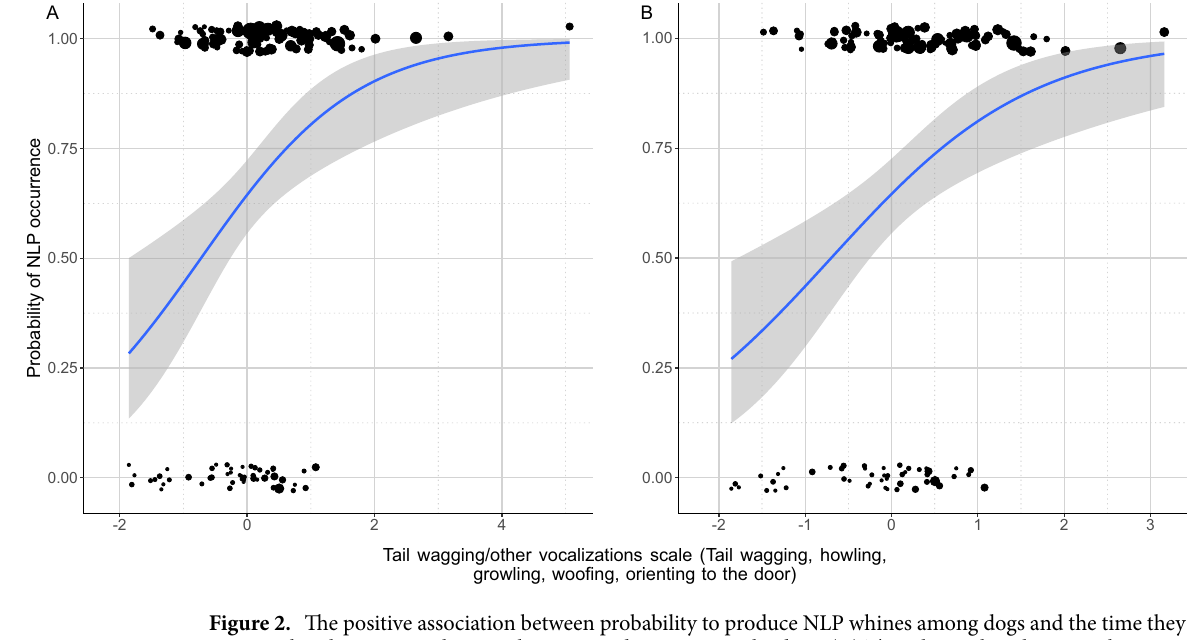
Figure 2. The positive association between probability to produce NLP whines among dogs and the time they spent with tail wagging, other vocalizations and orienting to the door. ( A ) The relationship shown in the original dataset, ( B ) the relationship shown after excluding the outliers. The size of the dots is proportional with the number of whines produced. The grey field shows the 95% confidence interval of the logistic fit.